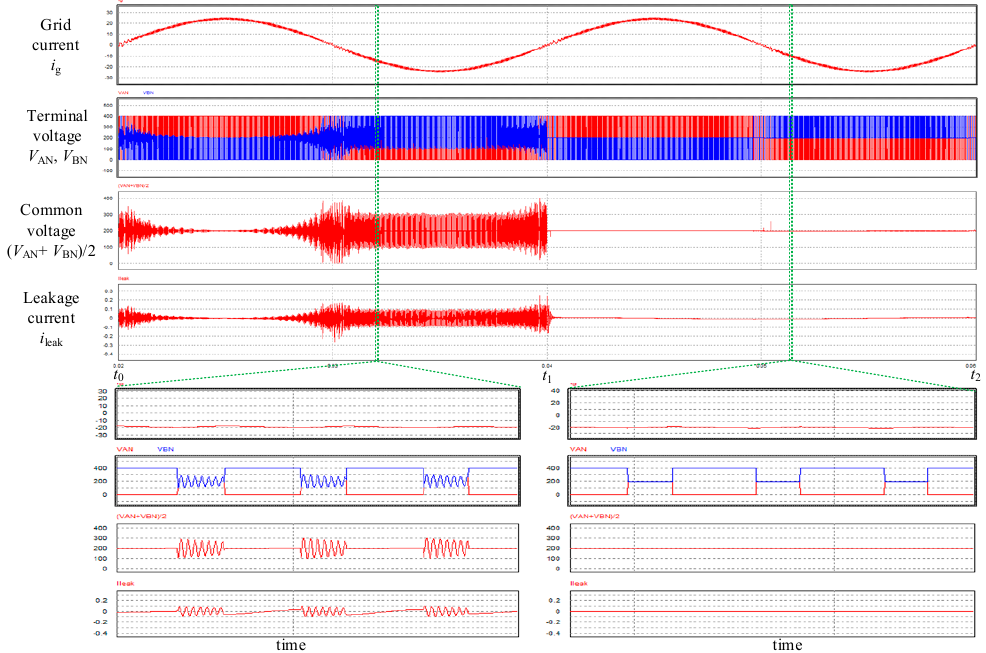
Figure 28. Waveforms of grid current, terminal voltage, CM voltage, and leakage current.